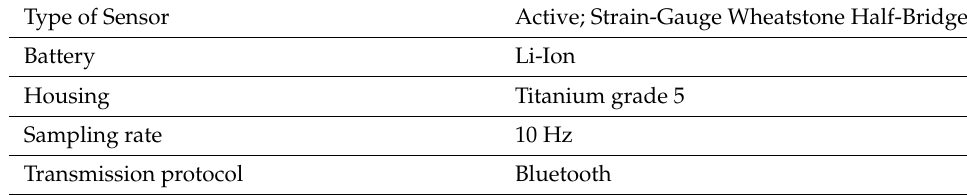
Table 1. The characteristics of the strain-gauge device.